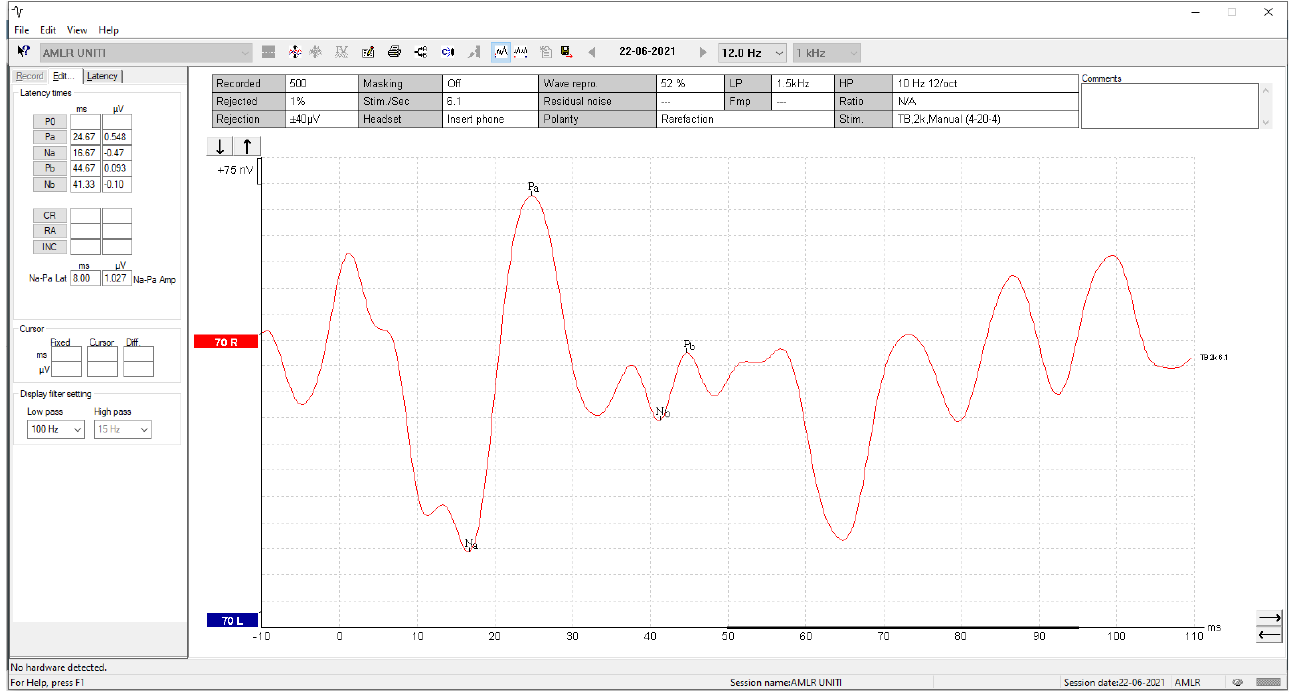
Figure 11. A screenshot of the selected AMLR waveform from the Interacoustics Interface.